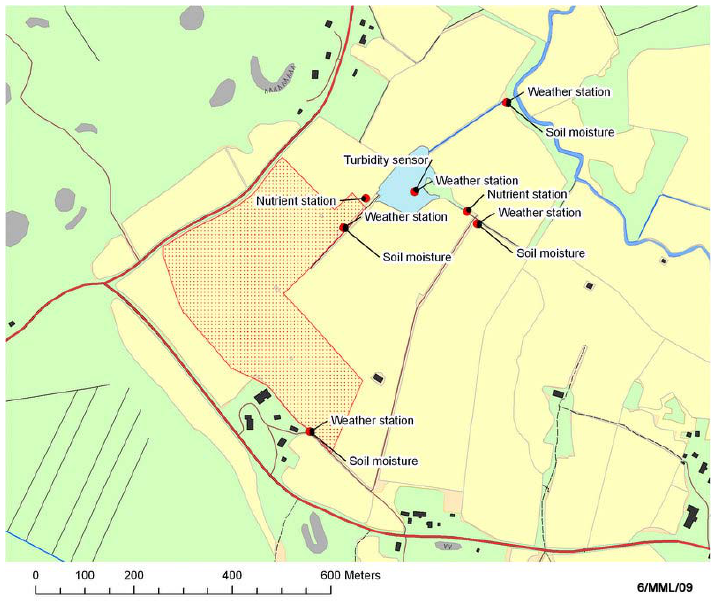
Figure 3. The locations of the SoilWeather WSN's weather stations, soil moisture sensors, nutrient stations and turbidity sensors in the area of Hovi